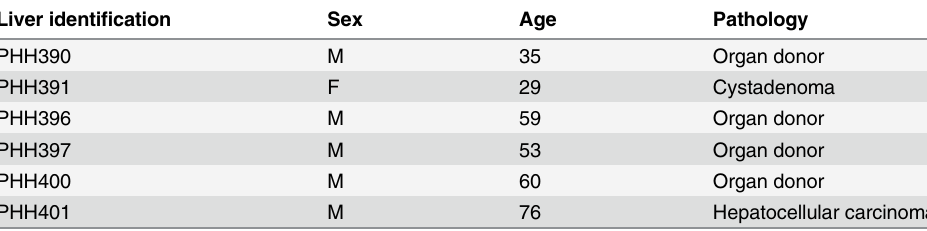
Table 1. Clinical characteristics of the liver